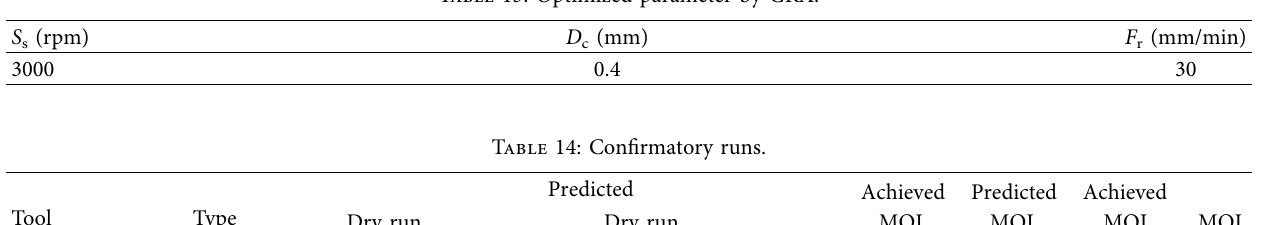
Table 13: Optimized parameter by GRA.